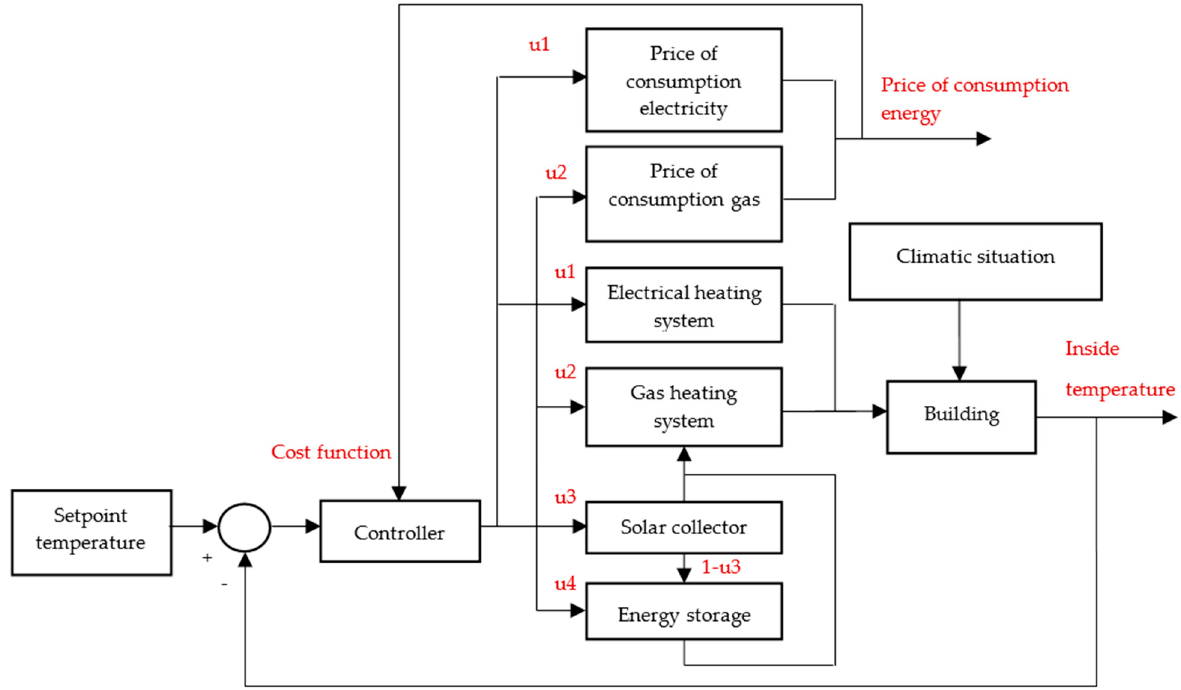
Figure 21. The overall control strategy applied to the building [167].